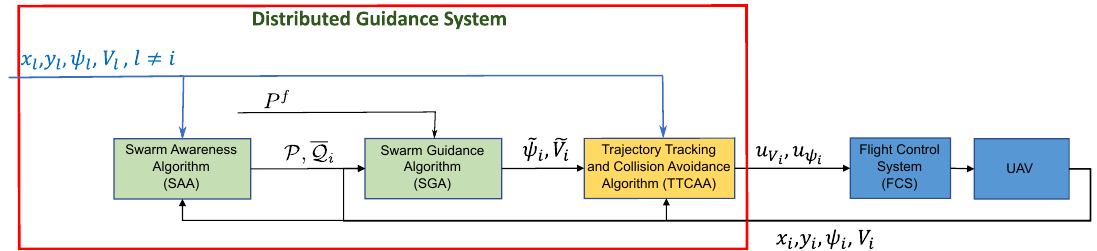
Figure 1. On-board guidance and control algorithm architecture (time information has been